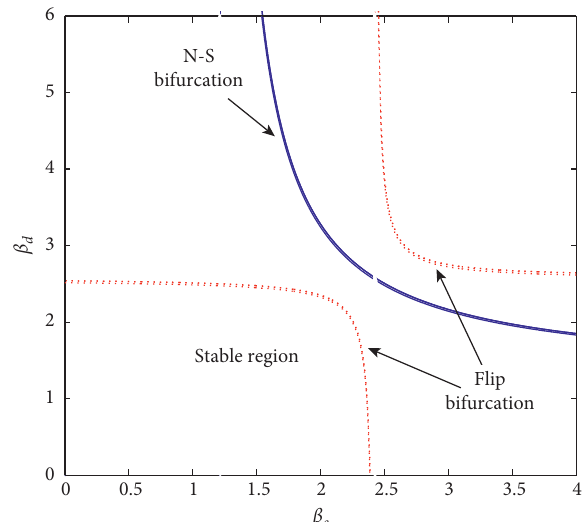
Figure 1: Stability region of the Nash equilibrium with respect to ( β